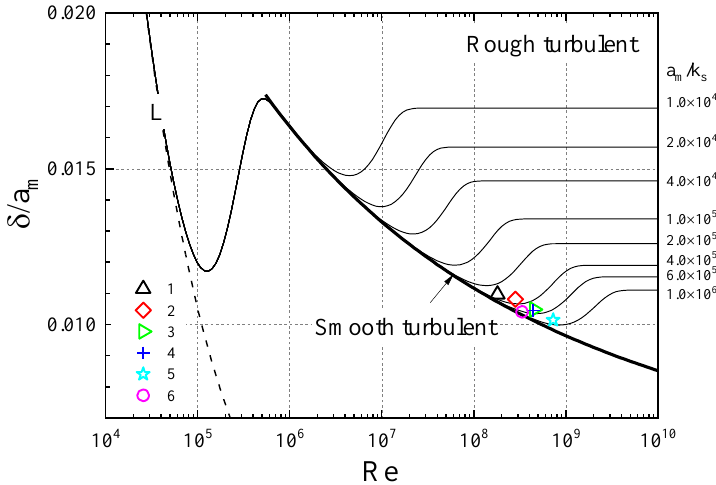
Figure 9. Bottom boundary layer thickness.